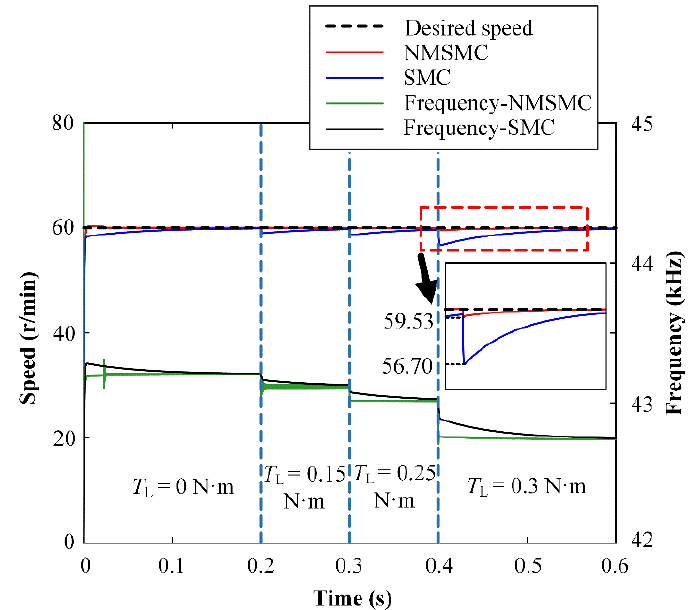
Figure 8. Simulation results of anti-load speed control for SMC and NMSMC.